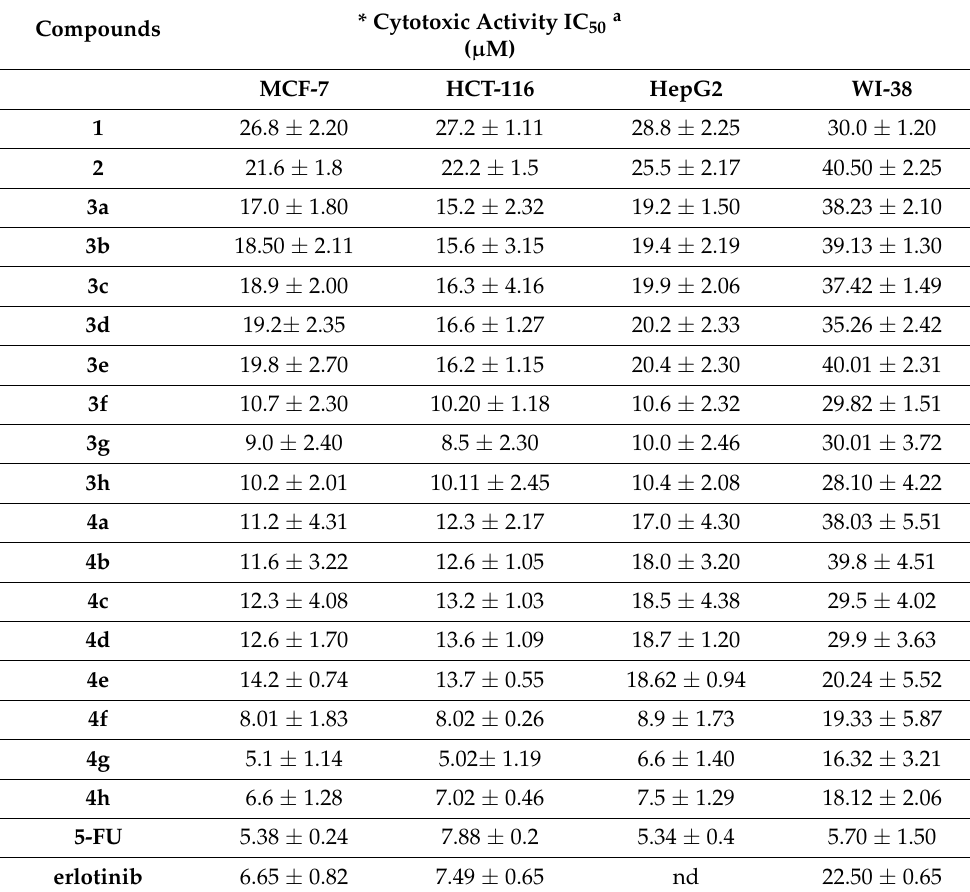
Table 1. Cytotoxic activity (IC 50 ) of compounds 1 – 4 against MCF-7, HCT-116, HepG2 and WI-38 cell